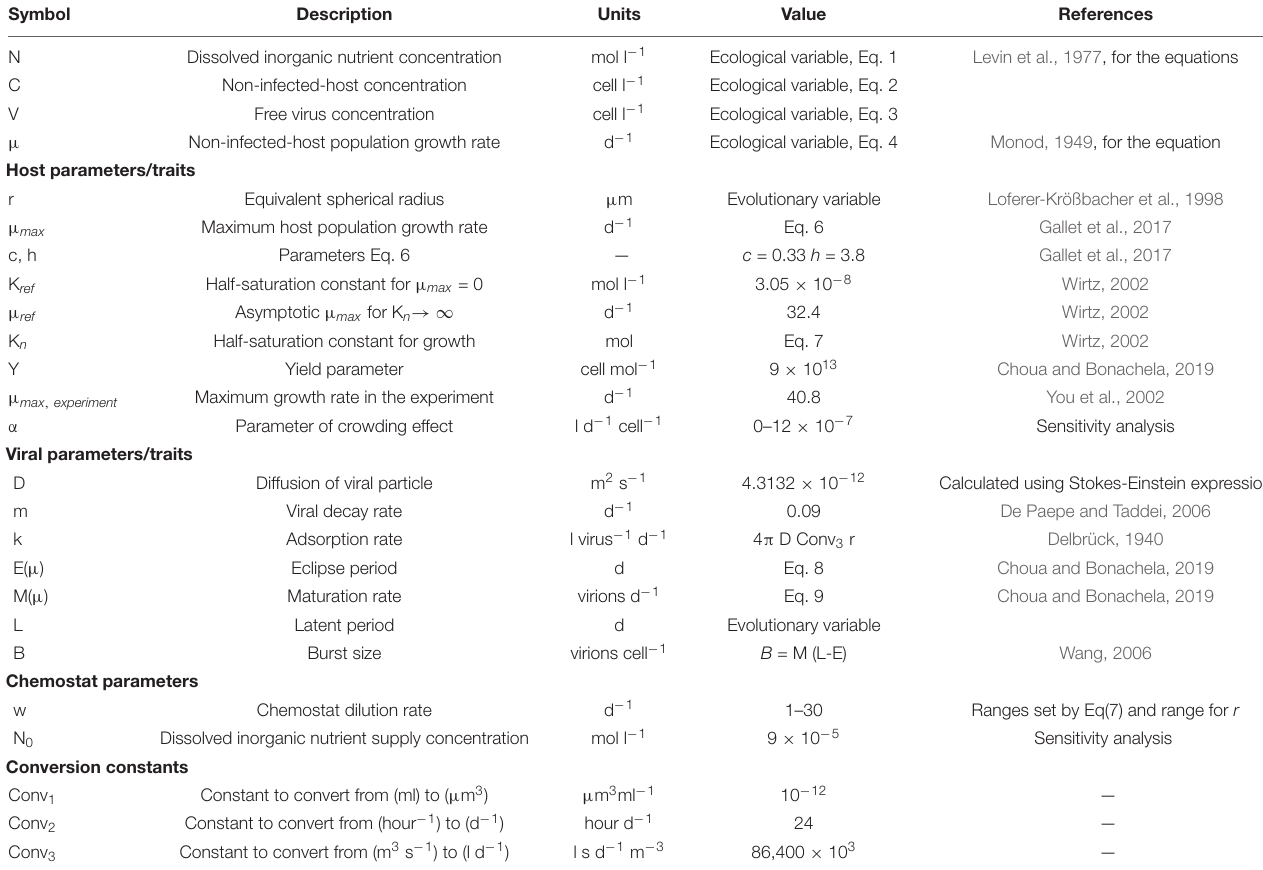
TABLE 1 | Symbols for variables and parameters used 1in the